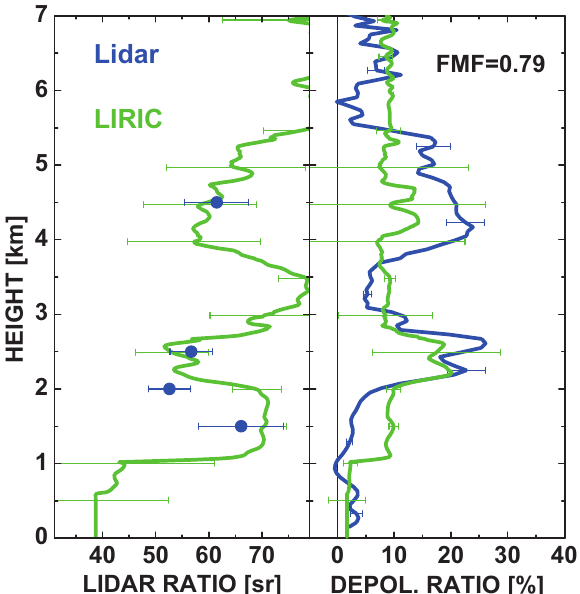
Fig. 12. Same as Fig. 6 except for a volcanic dust observation on 19 April 2010, 13:30–15:30UTC. Lidar signals are smoothed with 660m vertical window length in the case of the Raman lidar solu- tions for the lidar ratio.